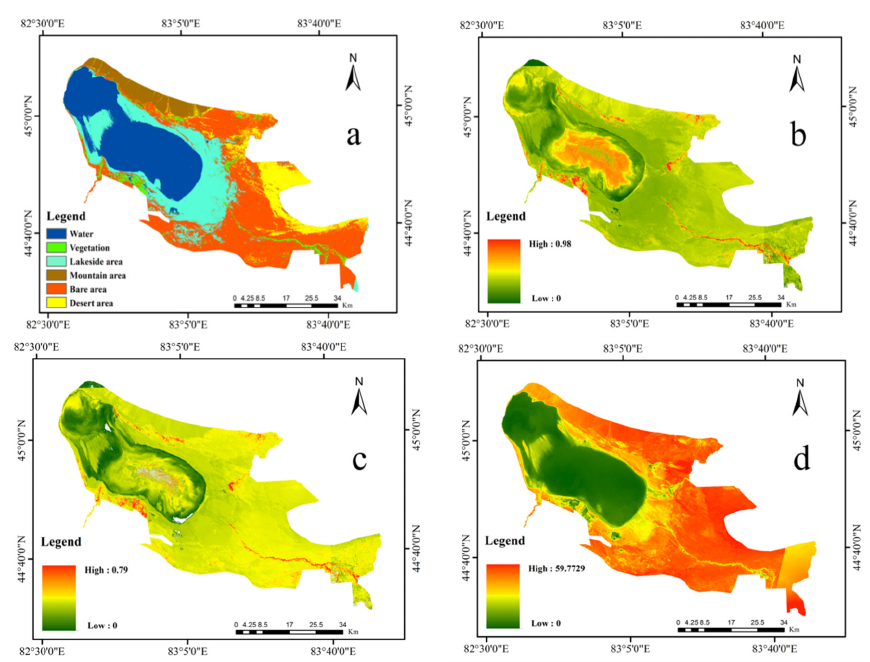
Figure 6. Data of salinization risk factors obtained by remote sensing in wet season: ( a ) spatial distribution of the LUCC risk factors; ( b ) spatial distribution of the NDVI risk factors; ( c ) spatial distribution of the PSRI risk factors; and ( d ) spatial distribution of the S_tem risk factors. NDVI, normalized difference vegetation index; S_tem, land surface temperature; PSRI, plant senescence reflectance index; LUCC, land-use/land-cover.